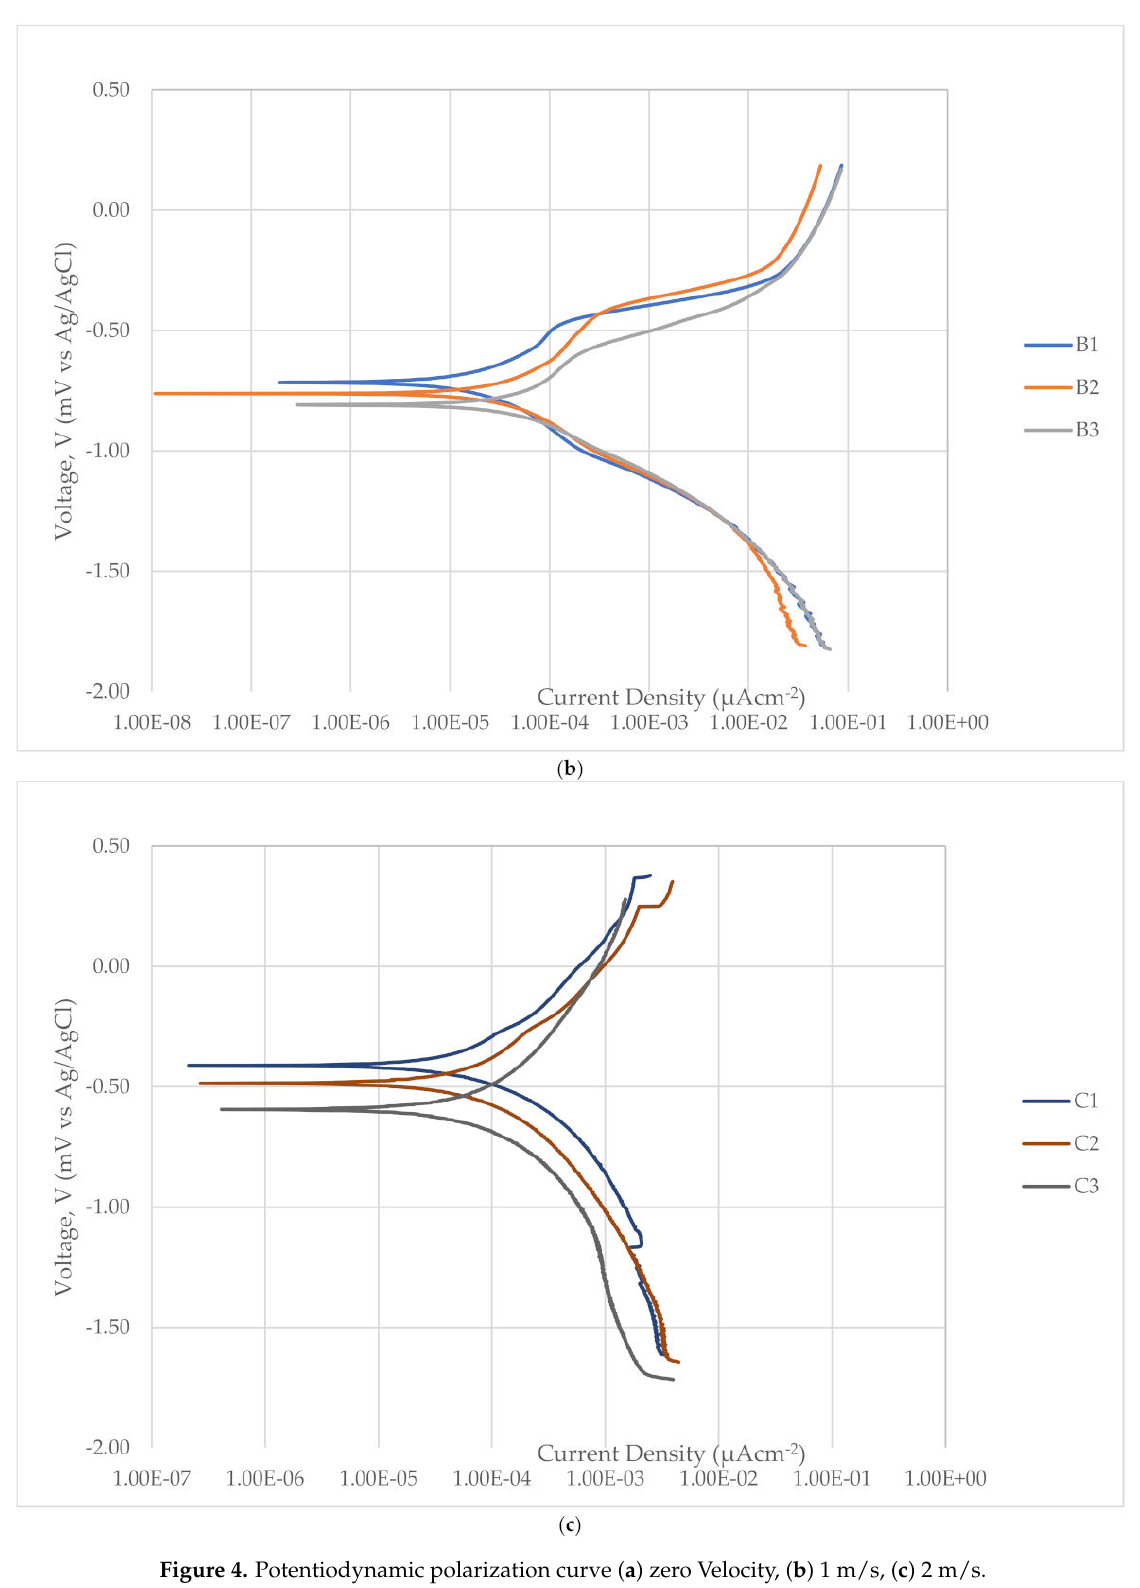
Figure 4. Potentiodynamic polarization curve ( a ) zero Velocity, ( b ) 1 m/s, ( c ) 2